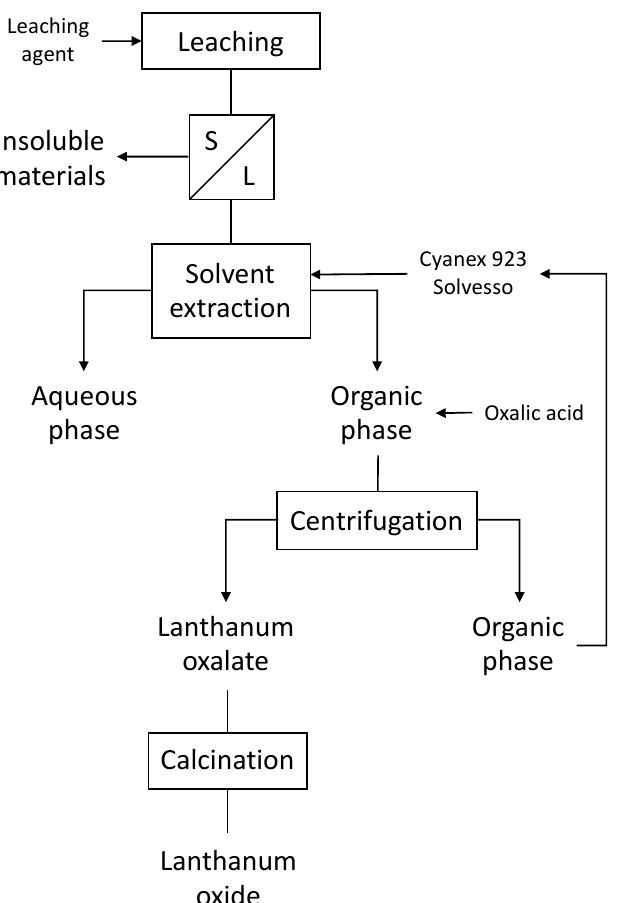
Figure 1. Schematic process for the obtention of lanthanum oxide.